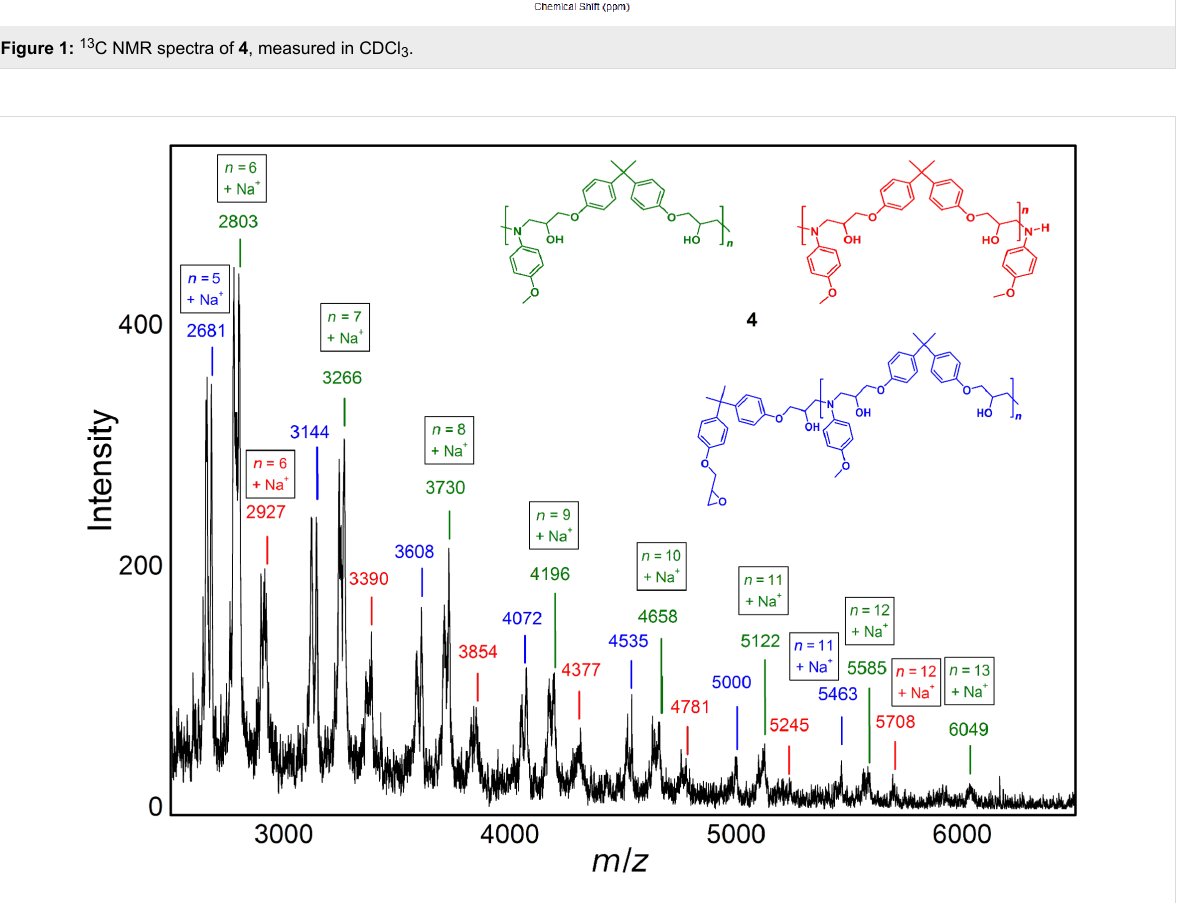
Figure 2: MALDI-TOF MS spectra (linear mode) of epoxide-amine product 4